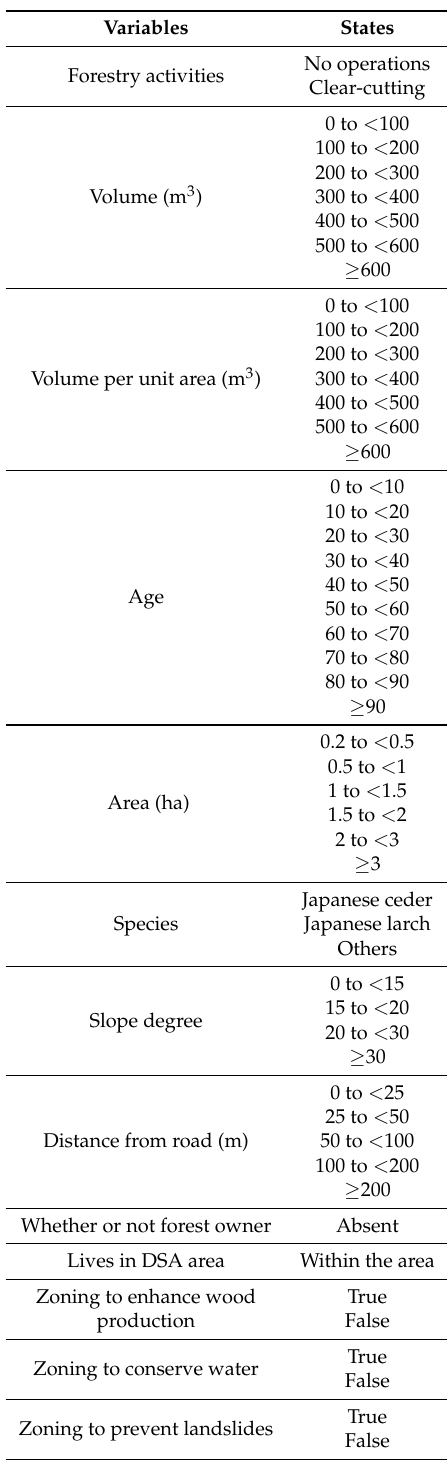
Table 1. Variables and states used for the model to reveal the influence of regional forest management on individual forestry